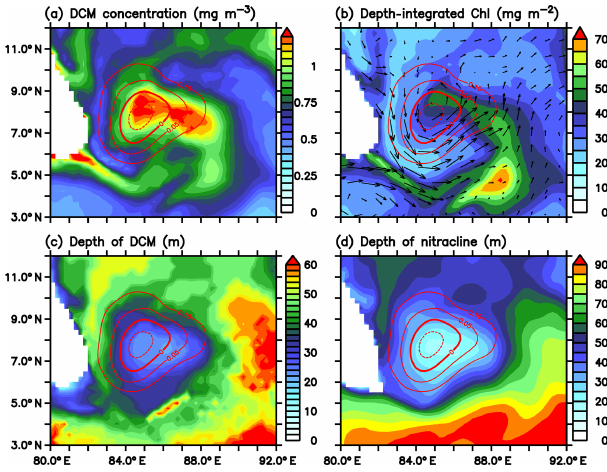
Figure 15. (a) Intensity of deep chlorophyll maxima (DCM;mgm − 3 ), (b) depth-integrated (100m) chlorophyll (mgm − 2 ), (c) depth of DCM (m), and (d) the depth of nitracline (m) for 1 July 2016 from the ecosystem model. Nitracline is defined as the depth of 2µmolkg − 1 nitrate isoline. Red contours in all the panels represent SLAs (m) in the region of the Sri Lanka